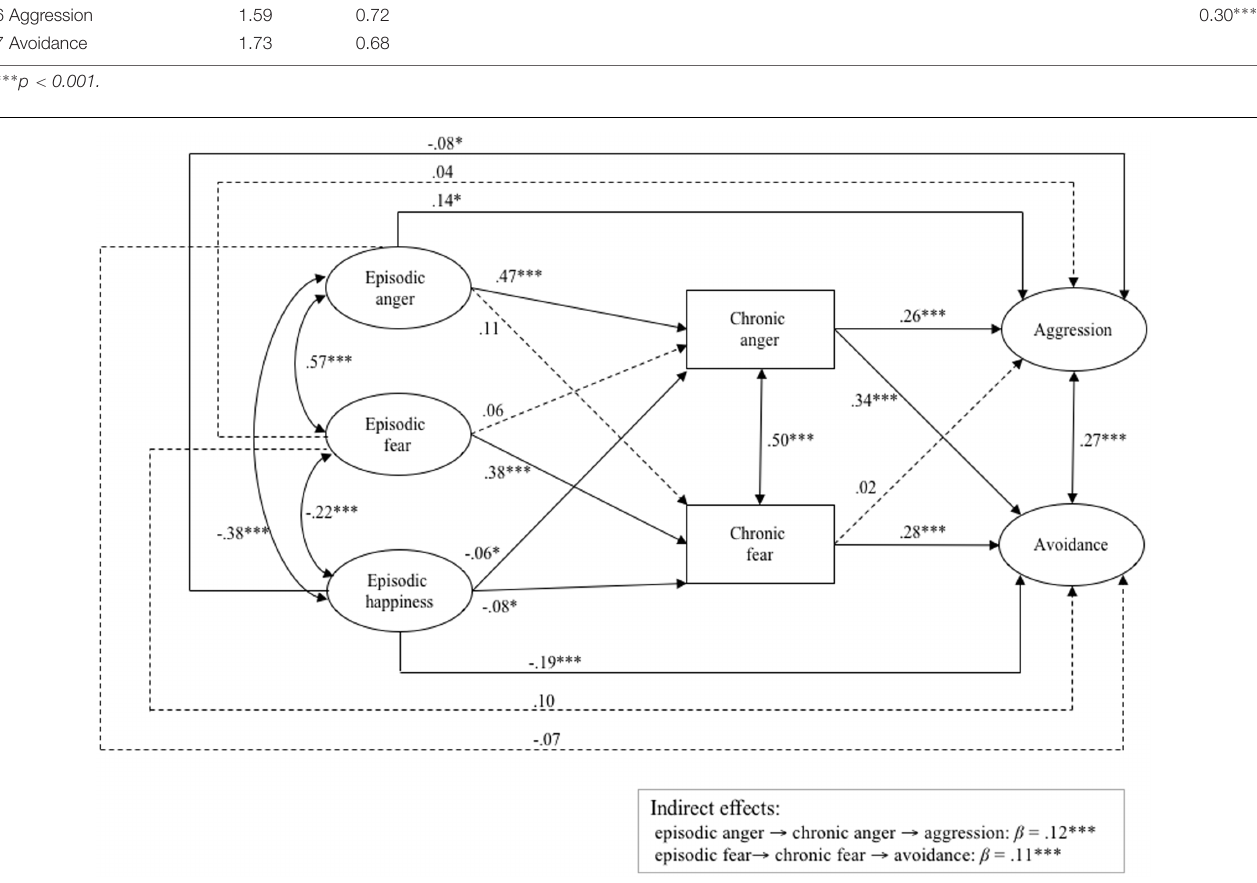
FIGURE 3 | Structural equation model tested in Study 3. ∗∗∗ p < 0.001, ∗ p < 0.05; standardized coefficients are shown. Continuous arrows indicate significant, and dashed arrows non-significant, relationships. Double-headed arrows indicate correlations. Indicator variables of latent variables and error variances are not included for simplicity; ( χ 2 = 52.98; df = 35; p < 0.001; CFI = 0.995; RMSEA = 0.018; SRMR =